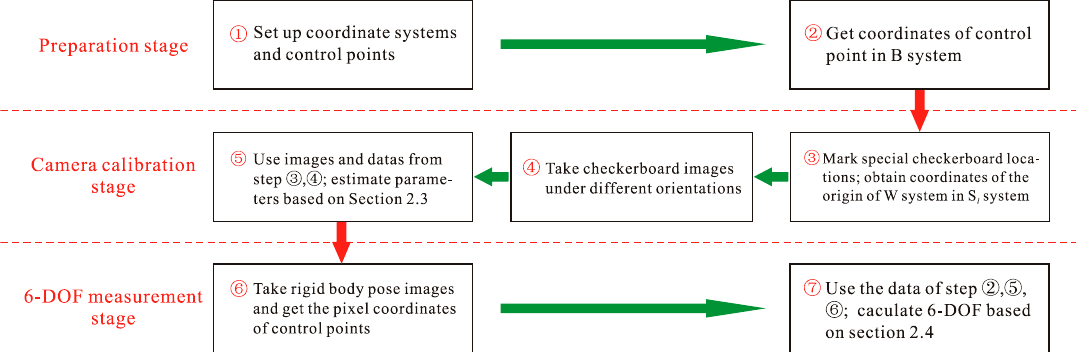
Figure 5. A universal method for six-degrees-of-freedom (6-DOF) measurement of rigid bodies.